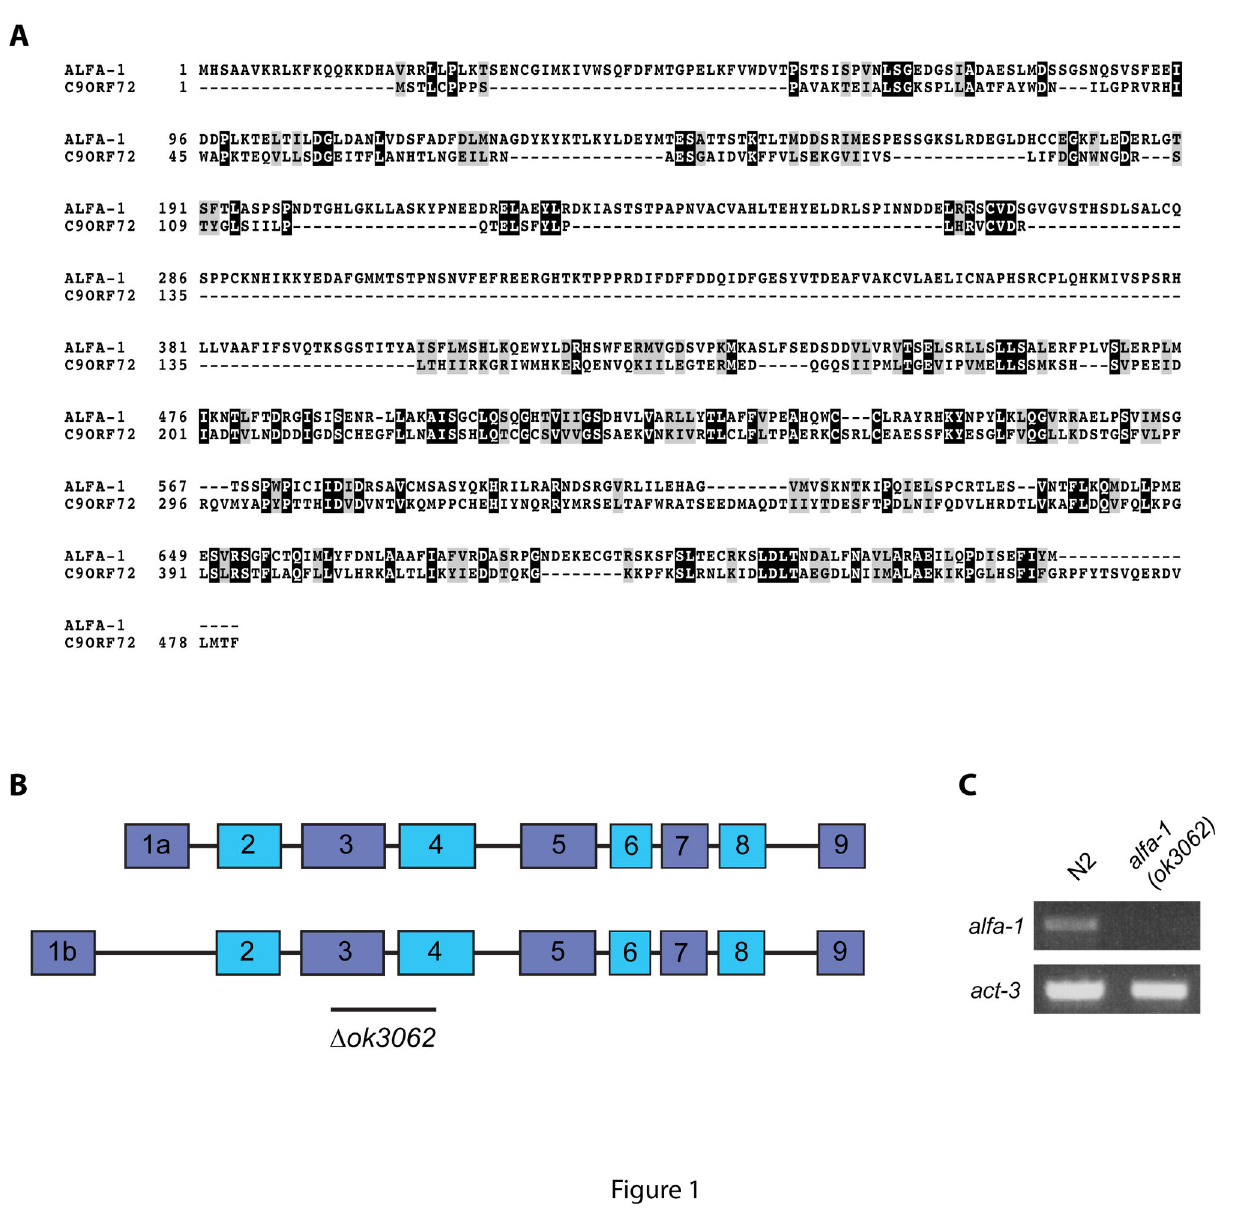
Figure 1. ALFA-1 is the orthologue of C9ORF72 in C. elegans . (A) Protein sequence alignment using Clustal W and BoxShade of C9ORF72 isoform 1 and ALFA-1 isoform 1. Overall, these sequences share 26% identify and 59 % similarity. (B) ALFA-1 has two predicted transcripts and the ok3062 deletion mutation spans exons 3 and 4 for both transcripts. (B) RT-PCR confirming the complete loss of expression of the alfa-1 transcripts. act-3 was used as a control.